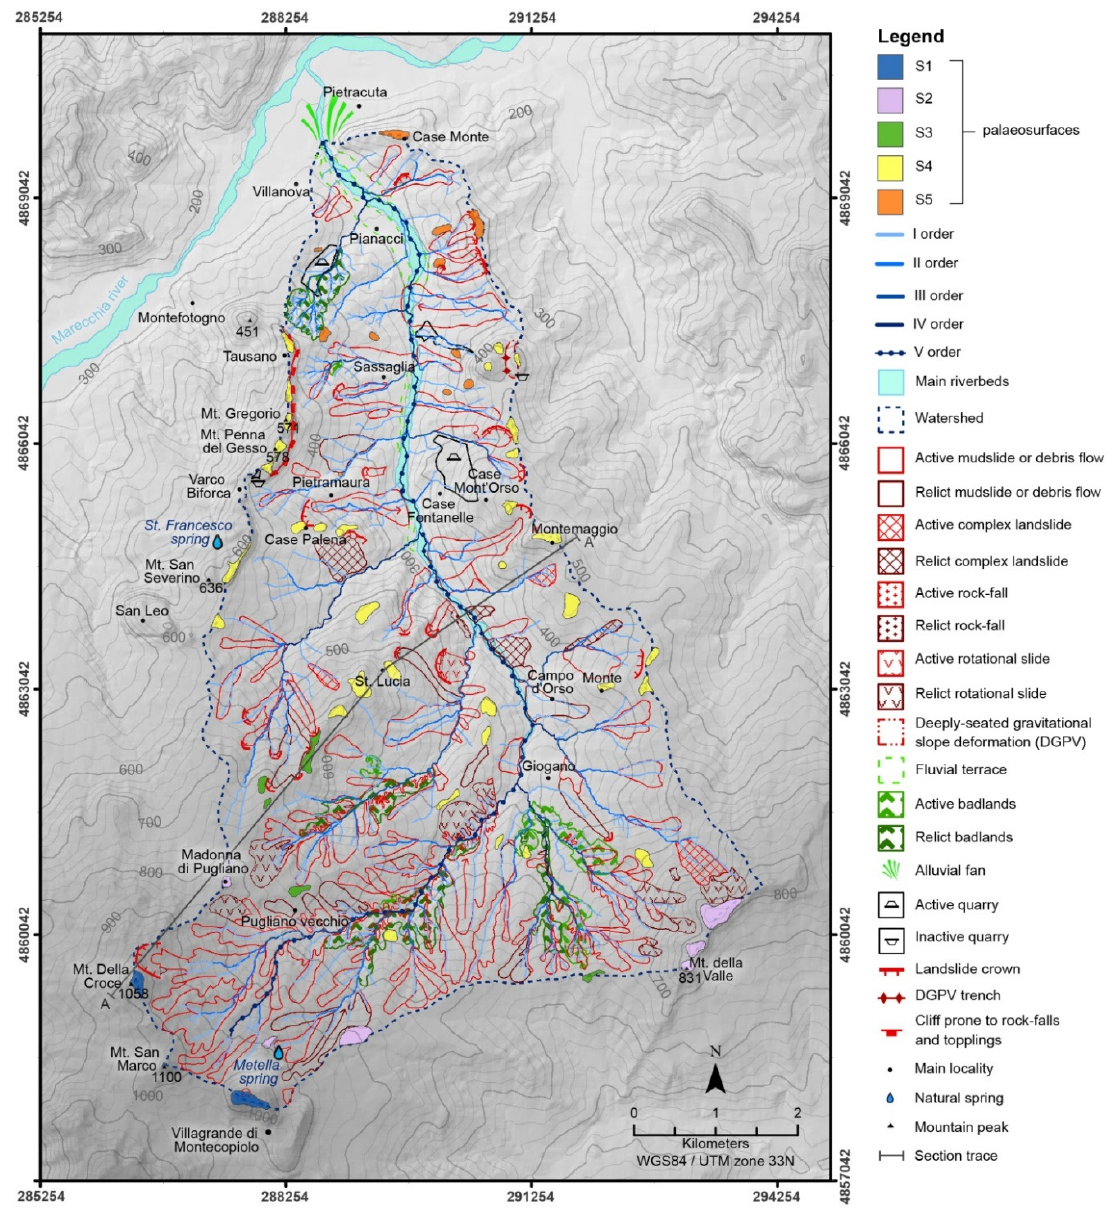
Figure 6. Geomorphological map of Mazzocco river valley.